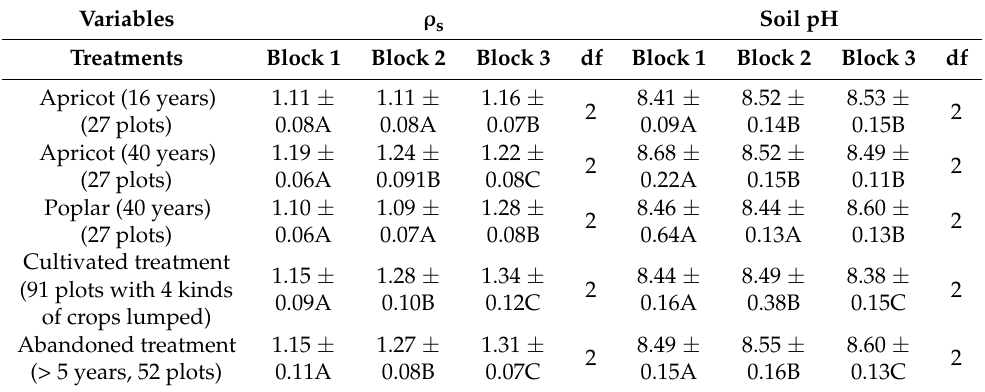
Table 1. The number of plots in each of the five treatments and soil bulk density ( ρ s ) and pH (to 1.0 m soil depth) of the different treatments in each of the three blocks. (mean ± standard